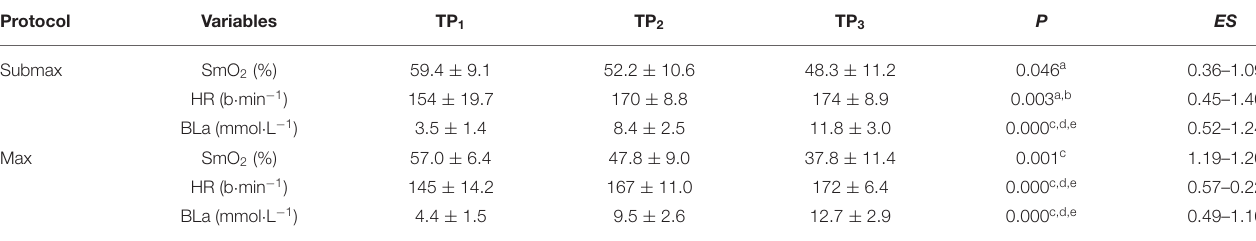
TABLE 1 | Statistical significance, effect size, muscle oxygen saturation, heart rate, and blood lactate values at all testing points during both protocols. Protocol Variables TP 1 TP 2 Submax